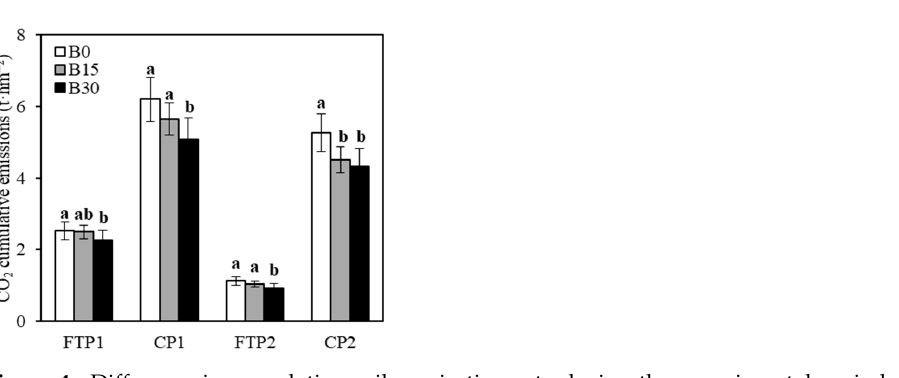
Figure 4. Difference in cumulative soil respiration rate during the experimental period. (Note: Different lowercase represents significant difference at p < 0.05 between treat- ments).